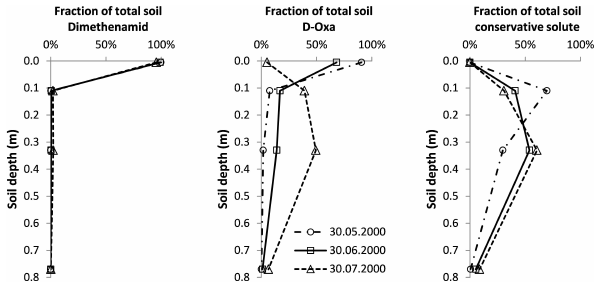
Fig. 7. Modelled distribution of relative Dimethenamid, D-OXA and conservative solute masses in the mixing layer and the matrix of the three soil layers at different time